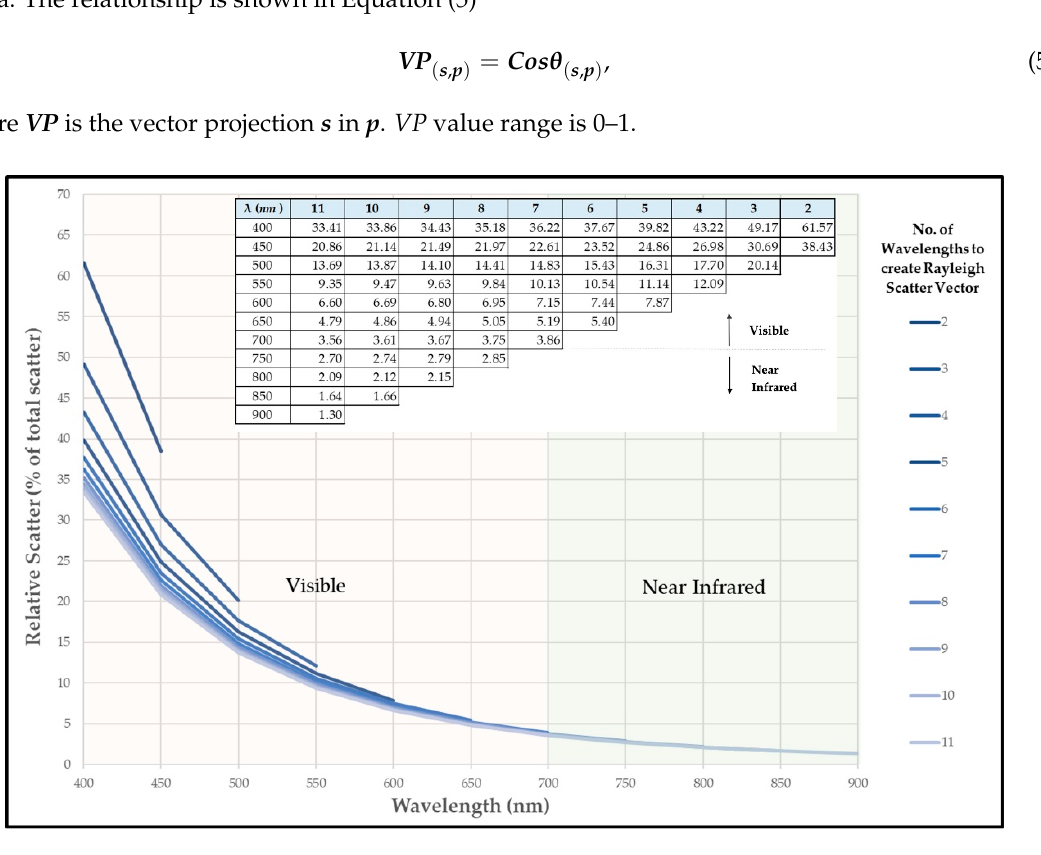
Figure 3. Rayleigh scatter vector signatures across the visible and near infrared spectrum wavelengths. Signature variation is caused by increasing or decreasing the number of wavelengths used to derive the Rayleigh scatter vector. the Rayleigh scatter